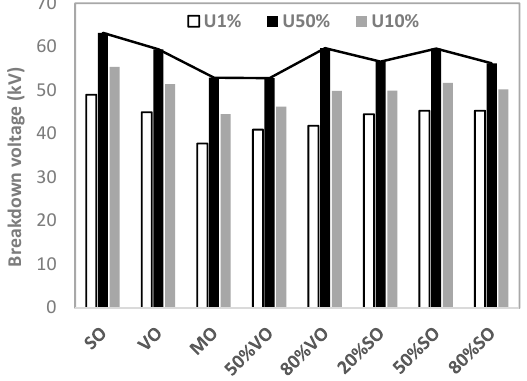
Figure 21. Probability of DC breakdown voltage of oil mixtures.